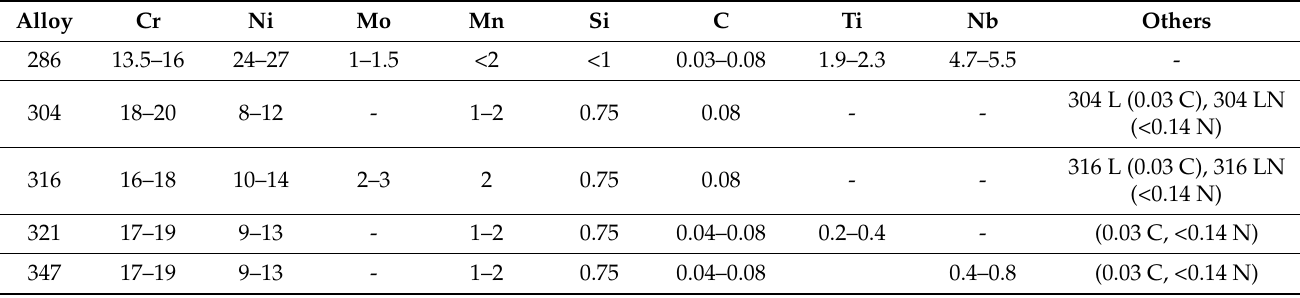
Table 1. Main constituents of commercial austenitic stainless steels used in nuclear reactors (wt%). L refers to low carbon and LN refers to low